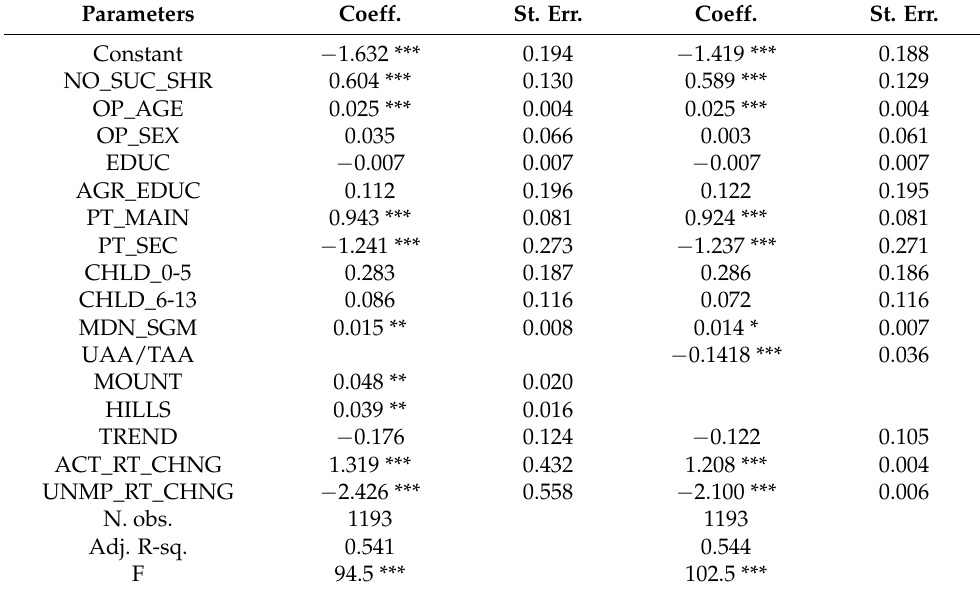
Table 3. Parameter estimates of the number of farms decrease rate model. Parameters Coeff. St. Err.